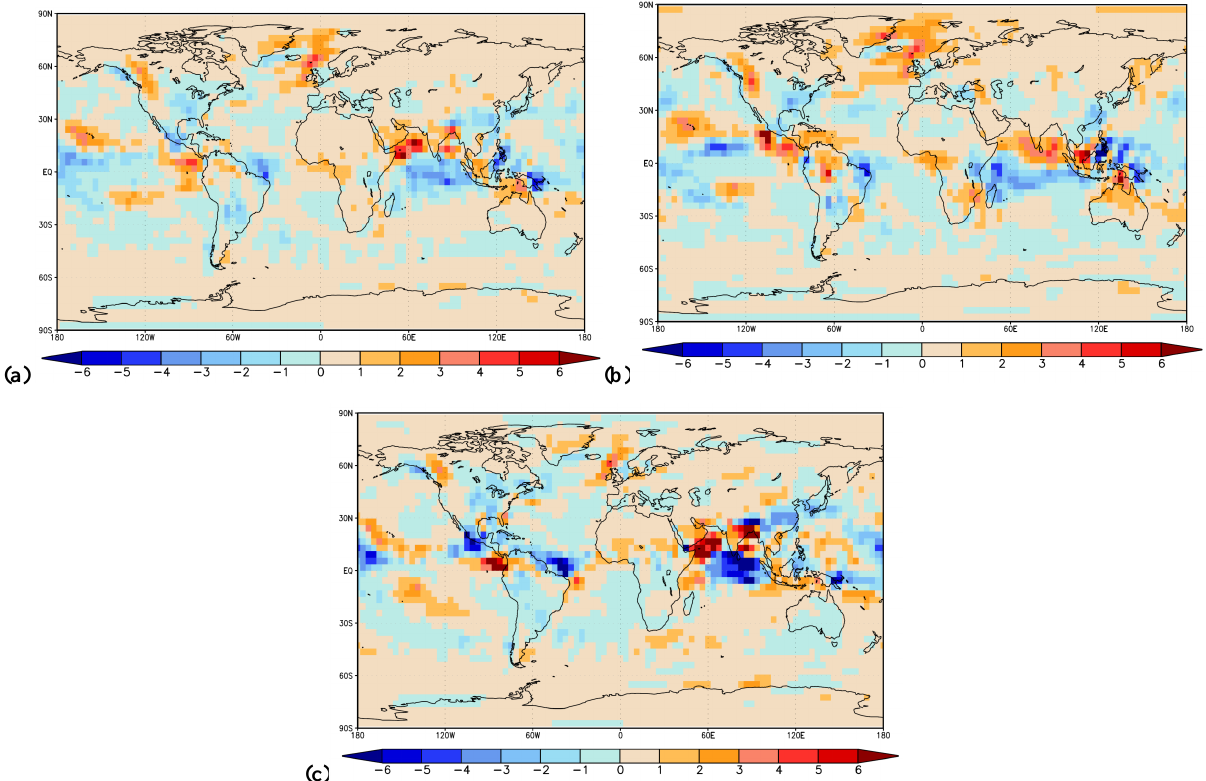
Fig. 10. Anomalies of precipitation in mm d − 1 between the mid-Pliocene and PI control runs of experiment 1. Shown are annual mean (a) , boreal winter season (DJF) (b) , and boreal summer season (JJA) (c) . Time averages have been calculated from a 30-yr